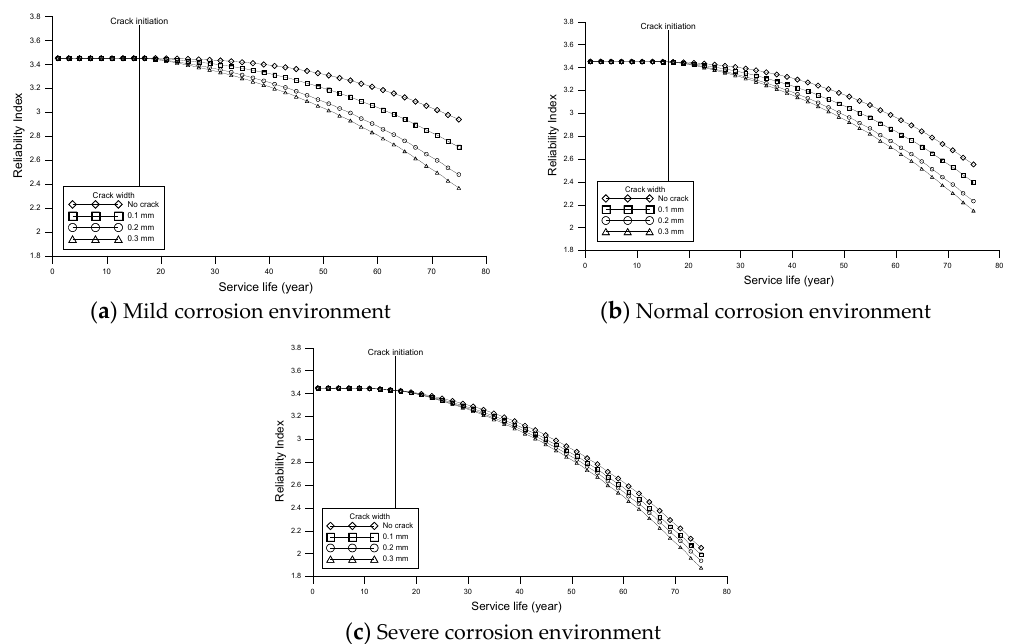
Figure 15. Reliability degradation considering crack width under normal traffic characteristics (calibrated model (1-W)).